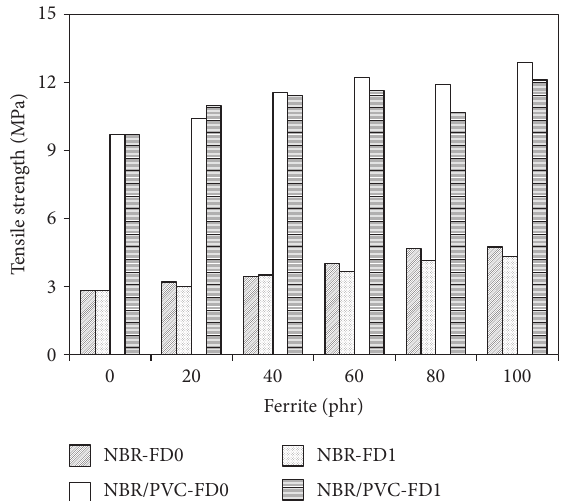
Figure 11: Influence of ferrites content on tensile strength of composites.